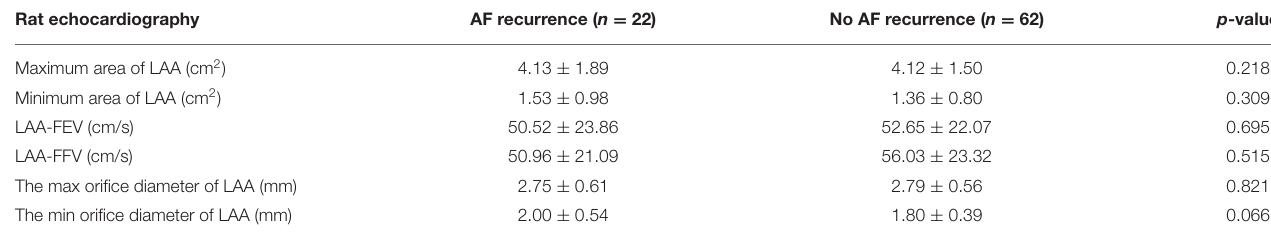
TABLE 6 | Parameters of LAA from TEE in patients with and without AF